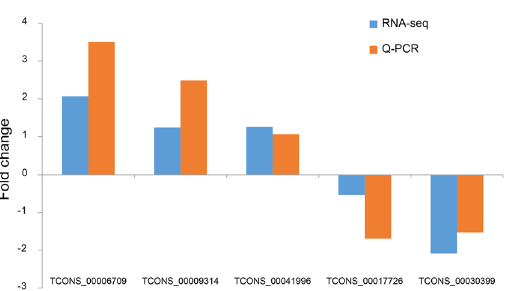
Figure 8. Validation of lincRNAs by qRT-PCR. The y-axis indicates the fold change of RNA-Seq and